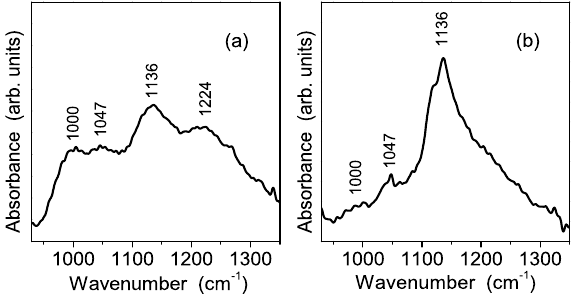
Figure 6. FT-IR ATR spectra of the synthesized sample showing typical features of the sulfate group SO 42 − recorded before (panel a ) and after (panel b ) the storage in high relative humidity environment. The details about the spectra detection are provided in the text.